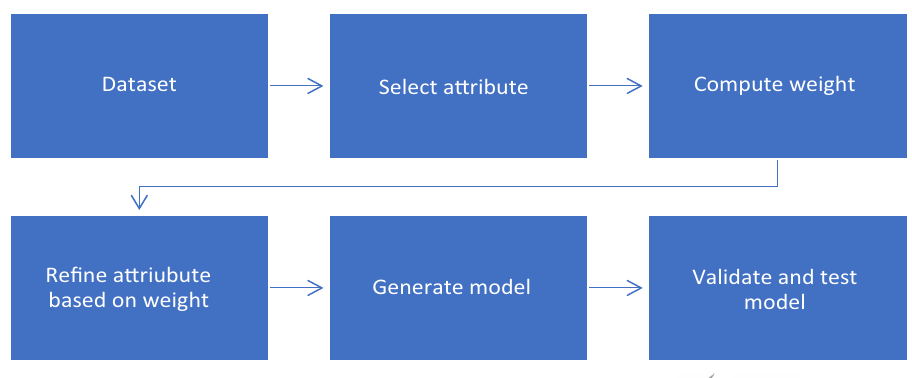
Fig. 1 A general sketch of the problem